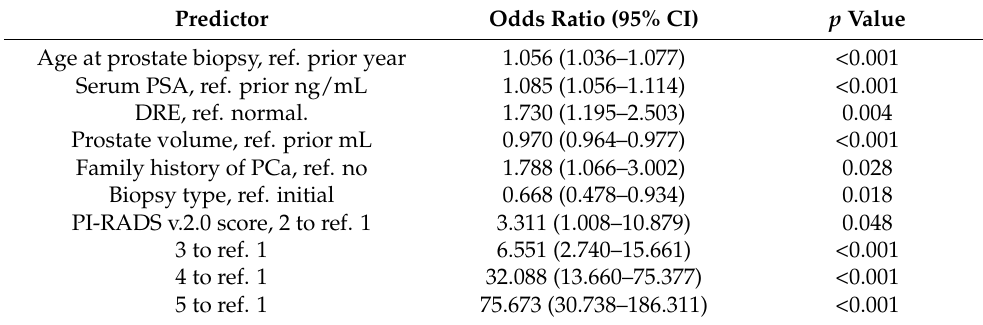
Table 2. Logistic regression analysis of independent significant predictors of csPCa in prostate biopsies.